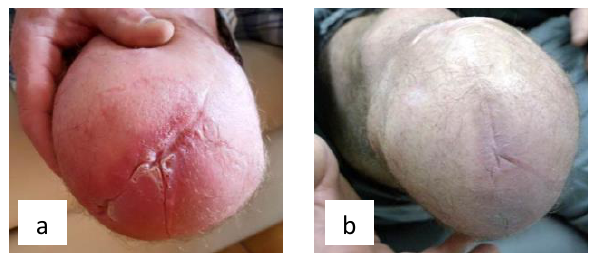
Figure 1: The condition of the Case #1 patient’s residual limb (a) before being fitted with a perforated liner and (b) after three months of use.